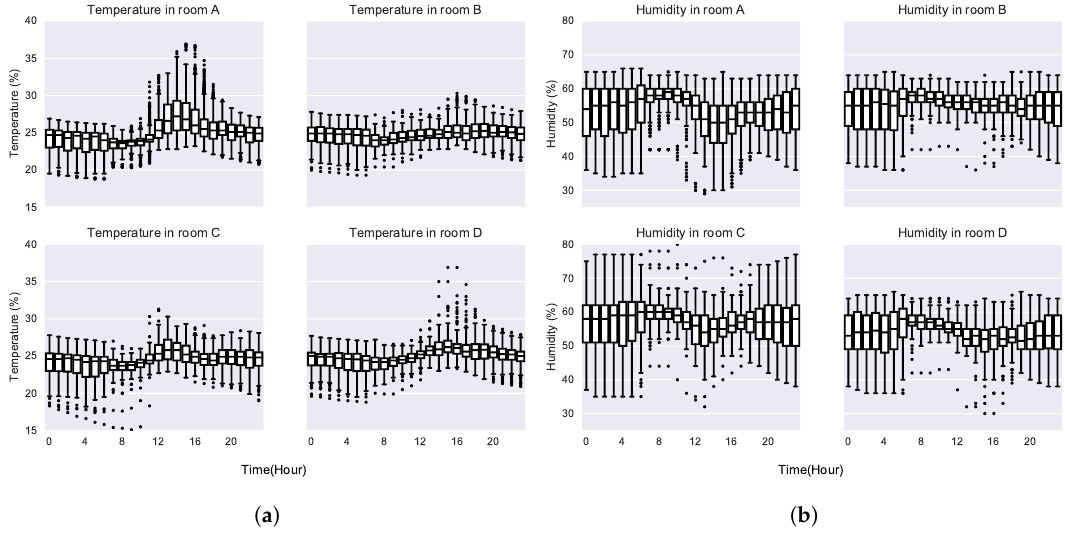
Figure 3. Temperature and humidity measurements in the monitored rooms: ( a ) temperature and ( b ) humidity measurements in each of the monitored